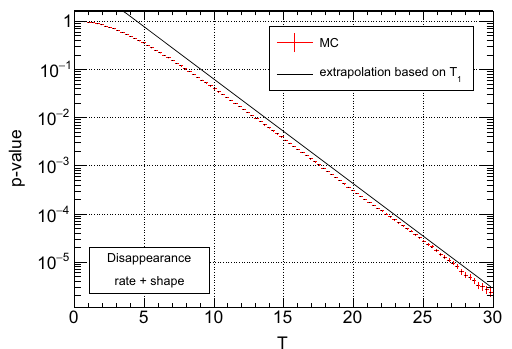
Fig. 10 Global p-value computed for the no-signal hypothesis as a function of the value of the test statistic T 2 . The distribution computed fromanensembleofpseudo-datageneratedundertheno-signalhypoth- esis (MC) is compared with the extrapolation based on T 1 and the pro- cedure discussed in the text. The value of the parameters used for the (cid:10) (cid:9) = 5 . 603, as estimated from 1000 N u extrapolation are u 0 = 1 and 0 sets of